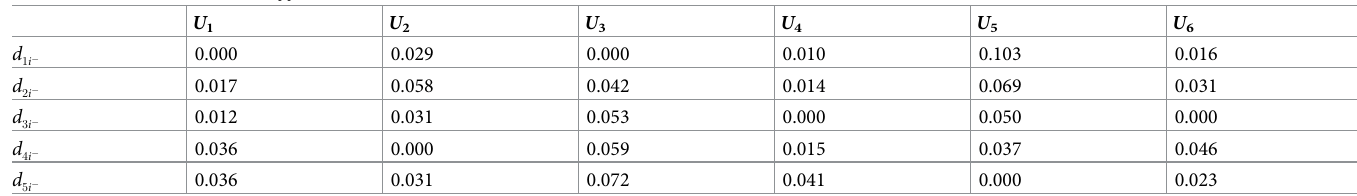
Table 8. The distance between γ ∗